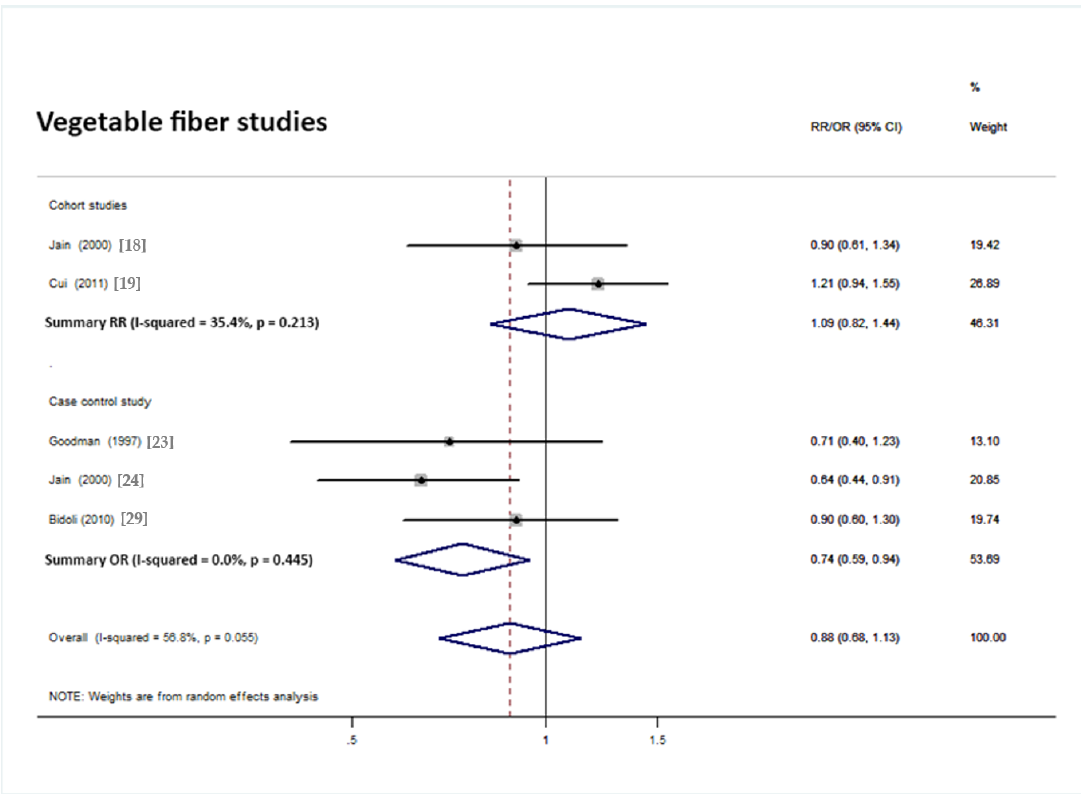
Figure 6. Forest plot of the summary risk estimate of endometrial cancer in the highest category of dietary vegetable fiber intake compared with those in the lowest category.